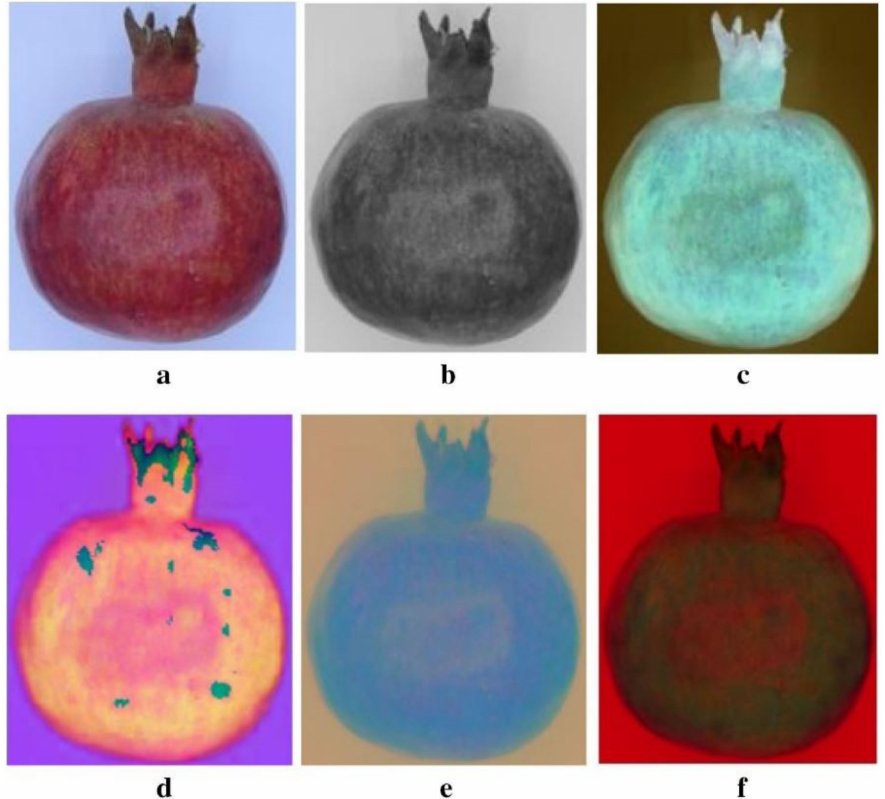
Figure 4. Different color images of pomegranate fruit using machine vision systems for quality grading. The color channels are described as ( a ): RGB, ( b ): gray scale, ( c ): CMY, ( d ): HSV, ( e ): YCbCr and ( f ): YUV. Adapted from